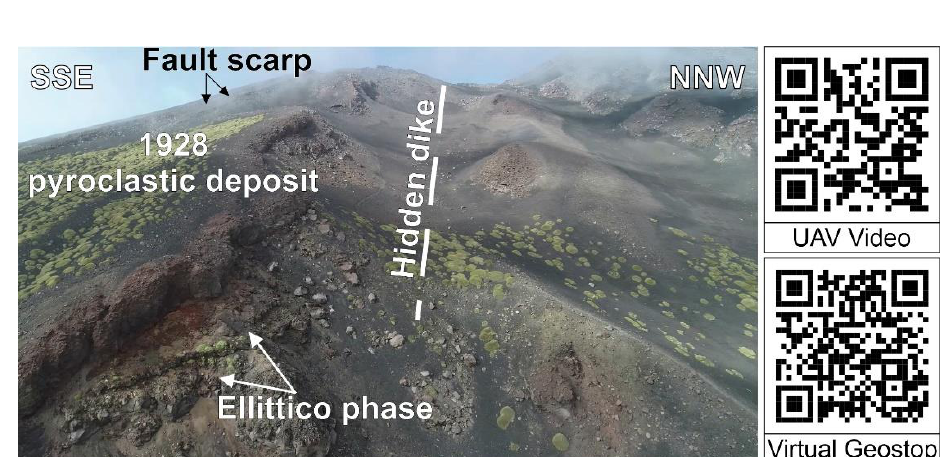
Figure 4. The image on the left shows geostop 2 through a WSW-looking UAV-captured picture. The QR codes on the right enable opening the corresponding UAV-captured video and the related VG. By using a mobile phone or a tablet, open up the QR code reader. Hold your device over a QR code, so that it is clearly visible on your screen. Press the notification and wait a few seconds. Figure 5. The image on the left shows geostop 3 through a SW-looking UAV-captured picture. The QR codes on the right enable opening the corresponding UAV-captured video and the related VG. By using a mobile phone or a tablet, open up the QR code reader. Hold your device over a QR code, so that it is clearly visible on your screen. Press the notification and wait a few seconds.